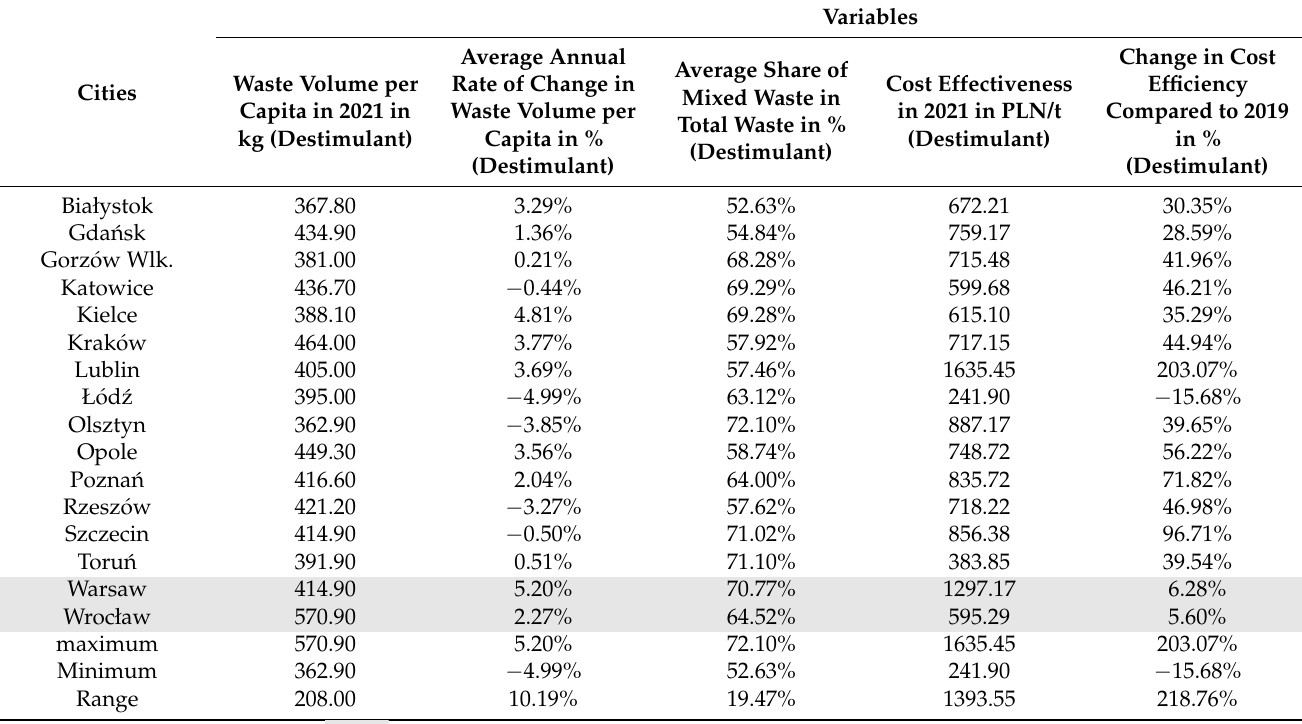
Table 2. Volume and average rate of change of municipal waste generated in the studied cities from 2019 to 2021 [in Table 5. Values of variables used in multi-criteria analysis of analyzed cities.